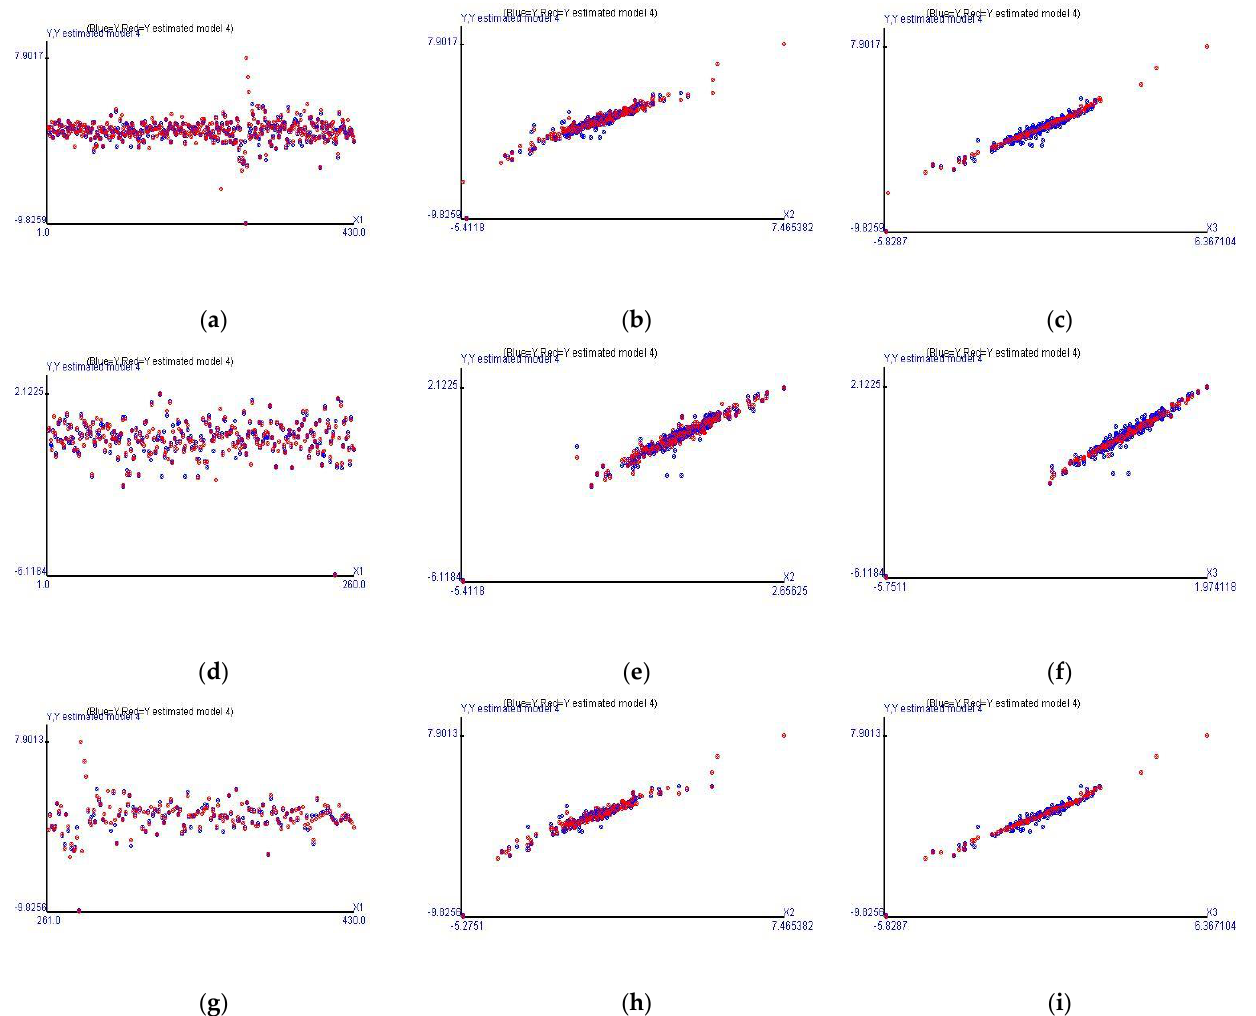
Figure 1. The actual and fitted values of Cases 1 to 3 on different horizontal axes. The first row is Case 1, the second row is Case 2, and the third row is Case 3. ( a , d , g ) are based on the horizontal axis as the time variable. ( b , e , h ) are based on the horizontal axis as the MSCI Morgan Taiwan Index Futures. ( c , f , i ) are based on the horizontal axis as Taiwan stock price index.